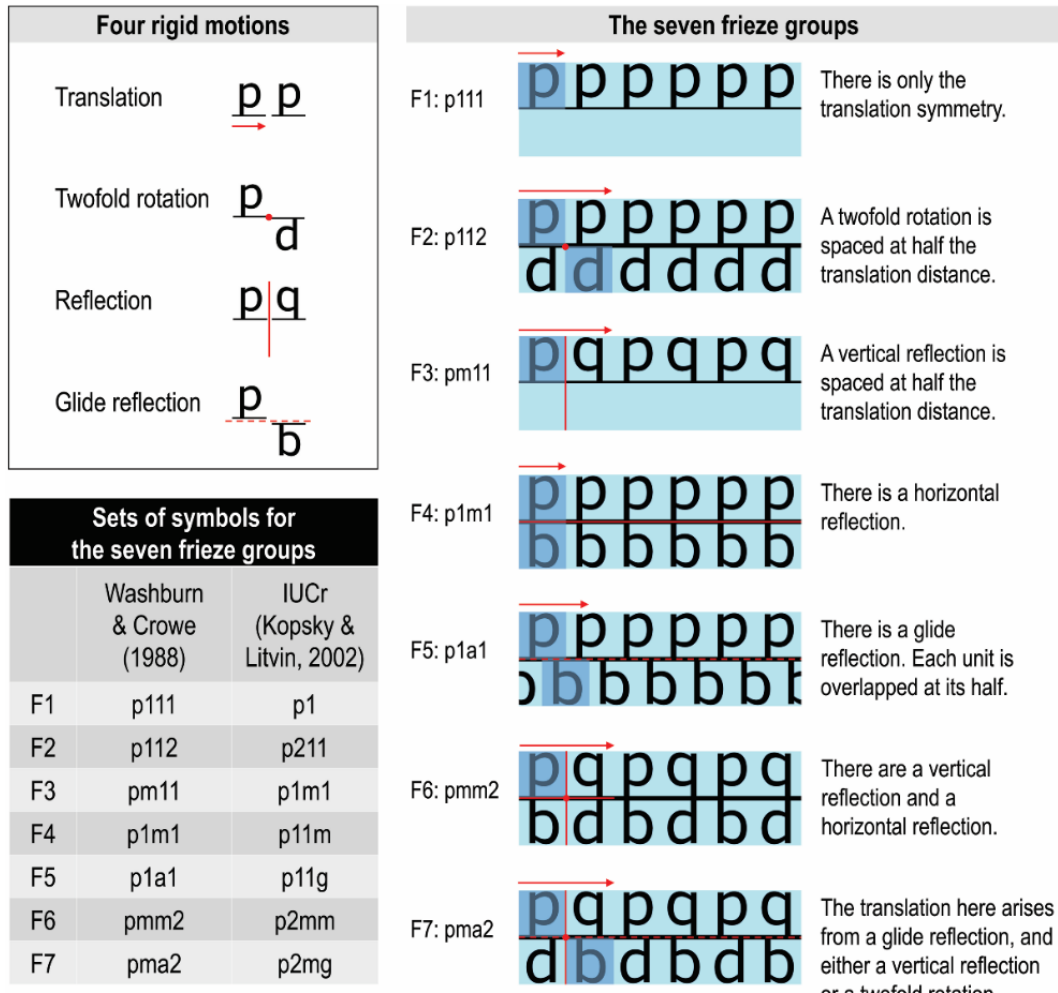
Figure 3. Seven frieze groups. Red arrows indicate translation distance. Red lines indicate axes of symmetry (horizontal and vertical). Dashed red lines indicate horizontal glide reflection axes of symmetry. Red dots indicate twofold rotation axes in each part. (Illustration by Kunkhet and Chudasri).